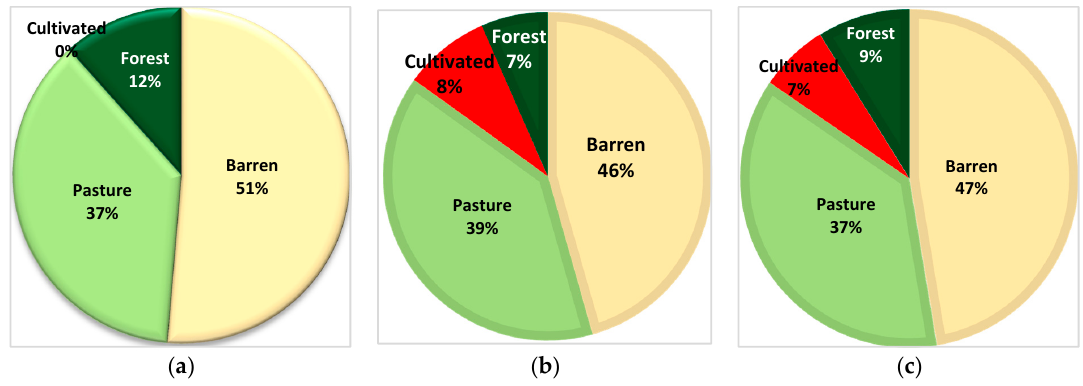
Figure 4. Percentage of land (PLAND) in the HSCZ for years ( a ) 1984; ( b ) 1998; and ( c ) 2015.